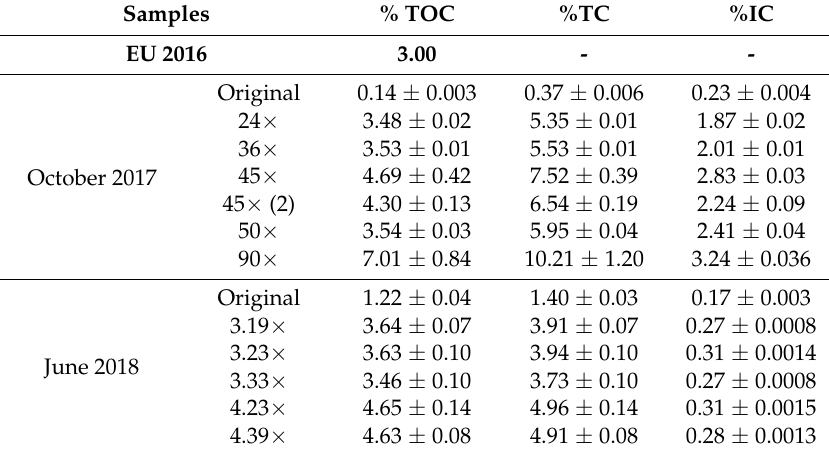
Table 2. Carbon content properties of original and concentrated leachates (October 2017 and June 2018).